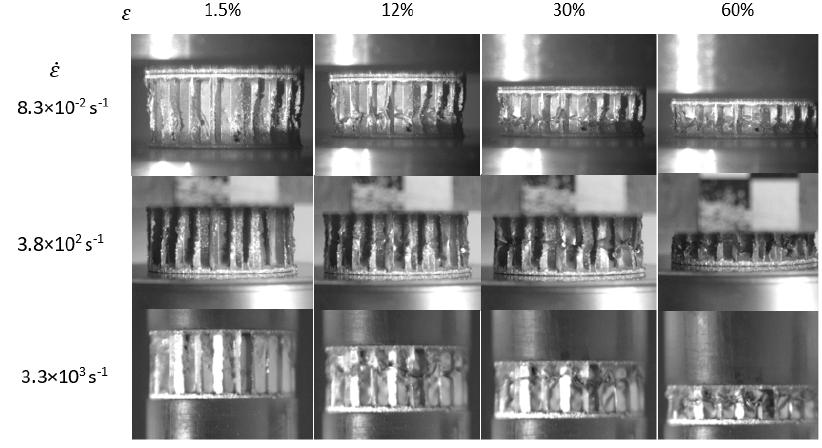
Figure 8. Frames recorded during series 1/8-5052-.0015 tests at different strain rates.